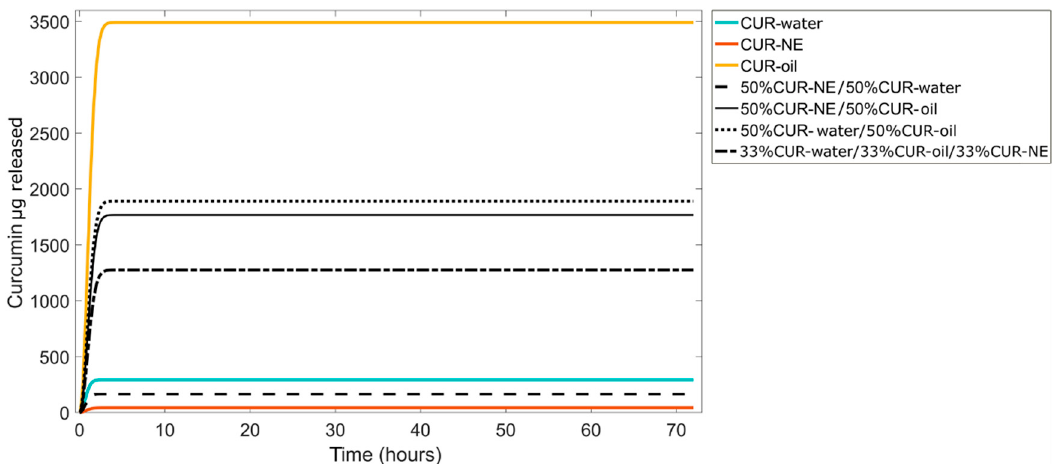
Figure 5. Predictive curcumin release kinetics can be obtained combining di ff erent CUR–water, CUR–oil and CUR–NE amounts by non-linear first-order